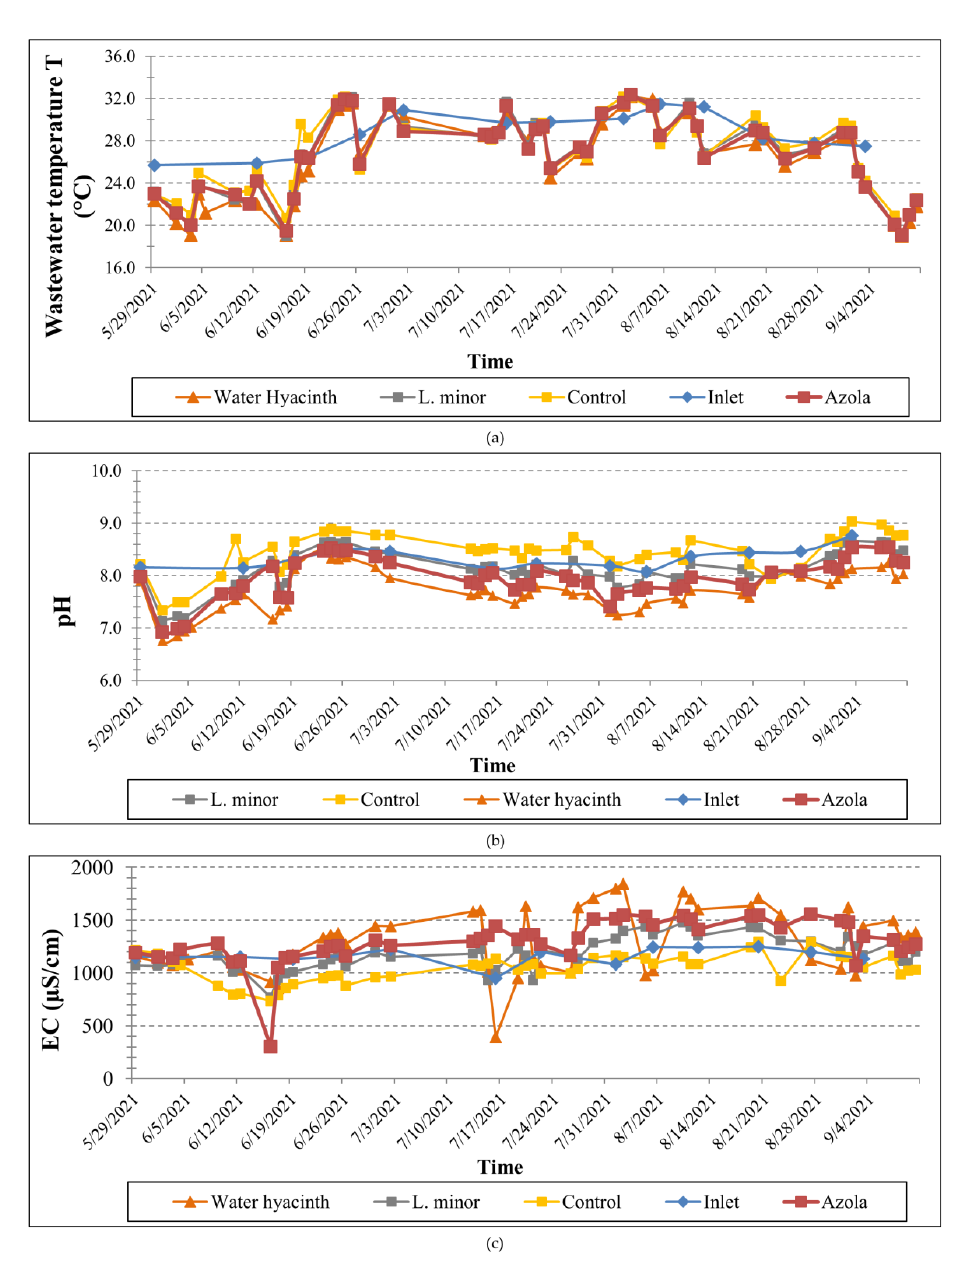
Figure 3. Temporal variation of ( a ) wastewater temperature, ( b ) pH and ( c ) electrical conductivity at the inlet and outlet of the four tanks throughout the operation period. Table 4. Removal percentages for the examined